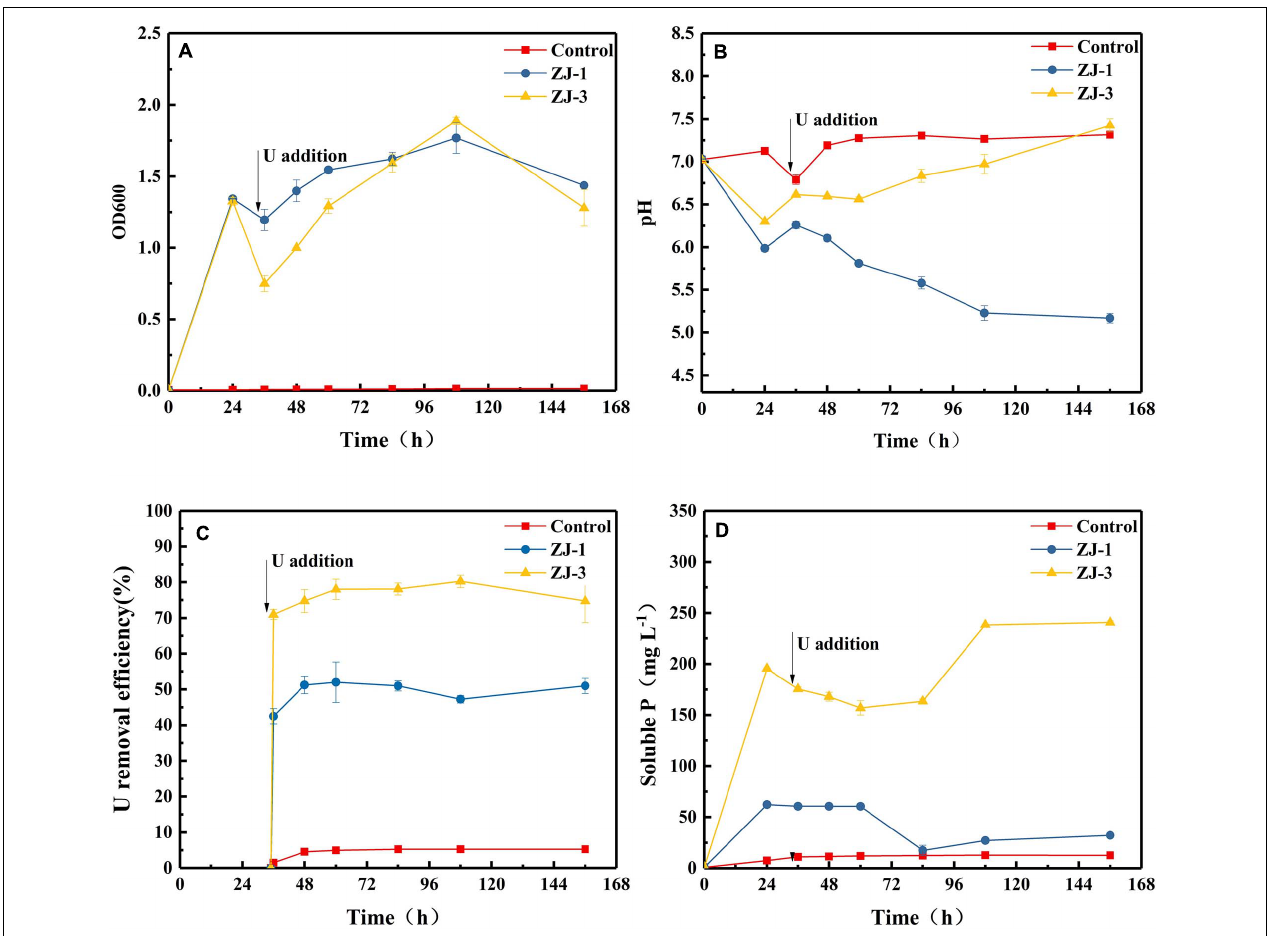
FIGURE 3 | PSB strains were incubated to evaluate G3P metabolism with concomitant U(VI) precipitation; (A) optical density at 600 nm (OD 600 ), (B) pH, (C) U removal efficiency, and (D) phosphate